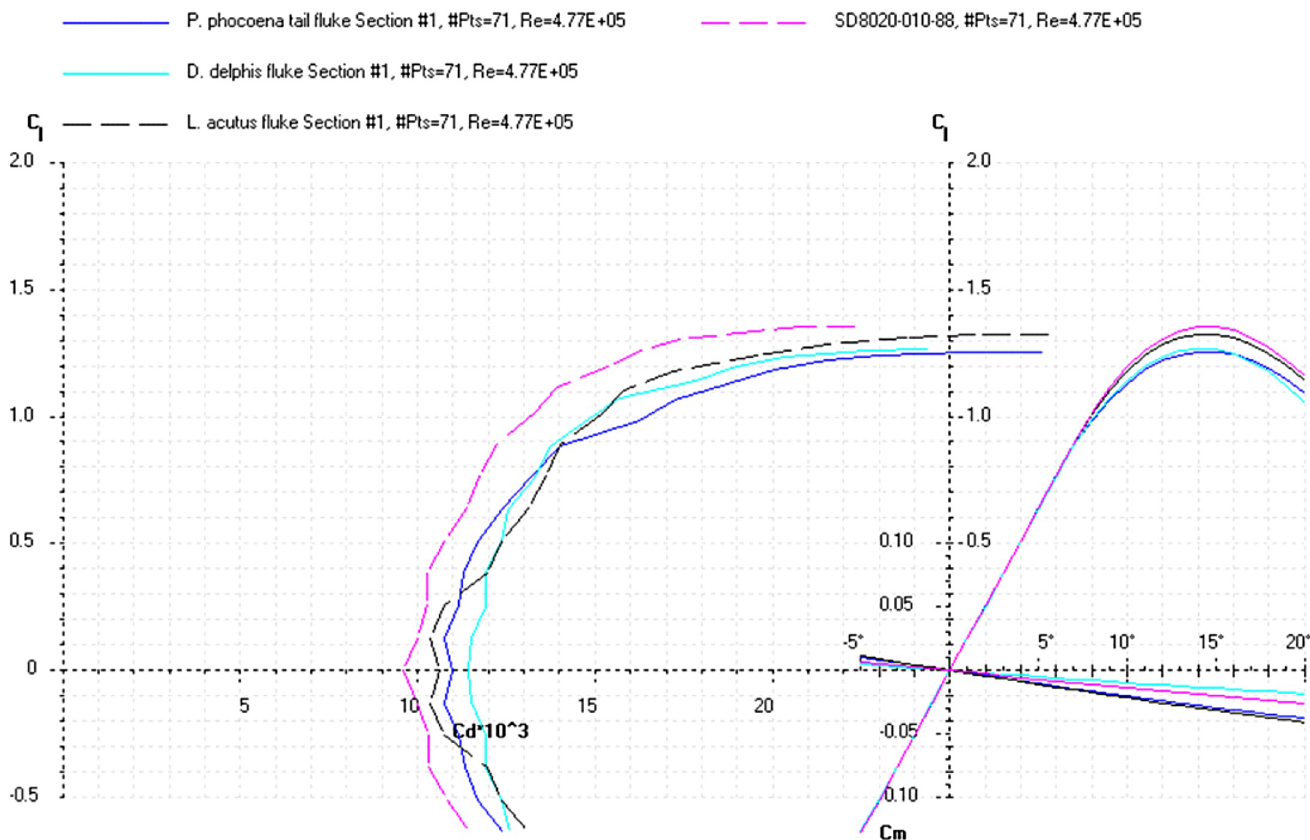
Fig 15. Drag polar diagram of lift CL vs drag Cd. Calculated for the cross-sections taken at the base of the tail flukes of the P . phocoena , D . delphis , L . acutus and SD8020 airfoil at the averaged Re 4.77E+05 for the fluke’s cross-sections (Table 10).